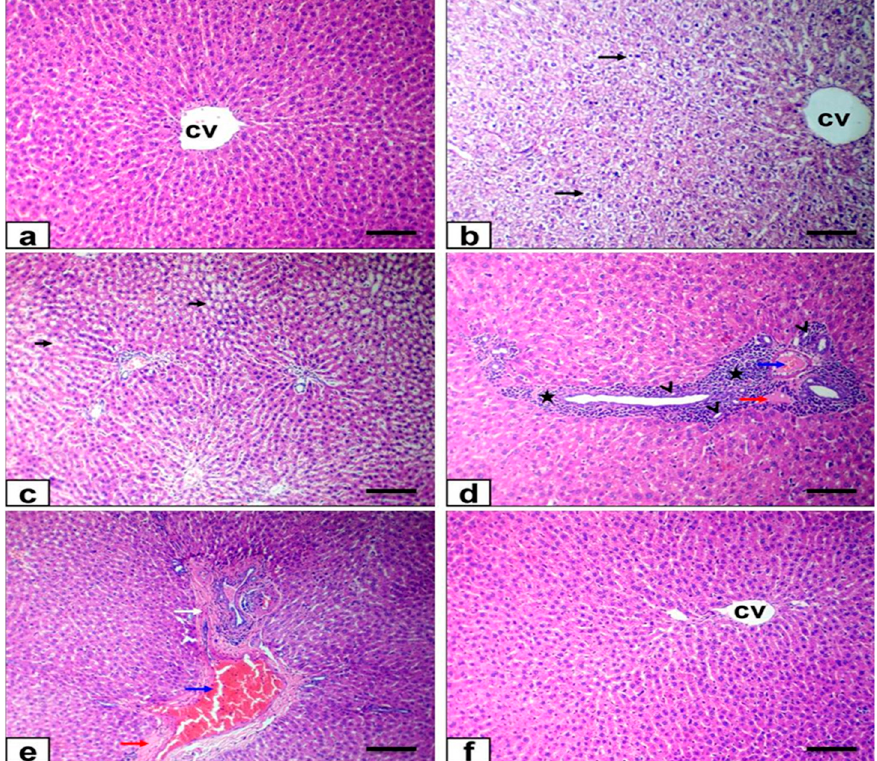
Figure 6. Photomicrograph of liver sections stained with HE: ( a ) liver of control group showing normal histoarchitecture ( b – e ) liver of malathion-treated rats showing diffuse hydropic degeneration of hepatocytes (long arrows)and dilatation of hepatic sinusoids (short arrows) beside intense mononuclear cells infiltration (stars), formation of newly formed bile ductules (arrowheads), congestion of portal vein (blue arrow), mild faint eosinophilic albuminous edema (red arrow), and mild fibroplasia (white arrow). ( f ) Ornipural ® with malathion-treated rats showing nearly normal histological structure. (Bar = 100 µm), CV = central vein.